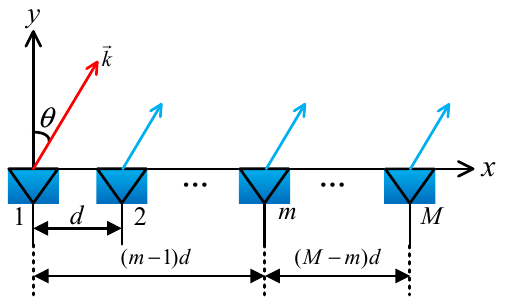
Figure 1. Configuration of a uniformly spaced linear array.